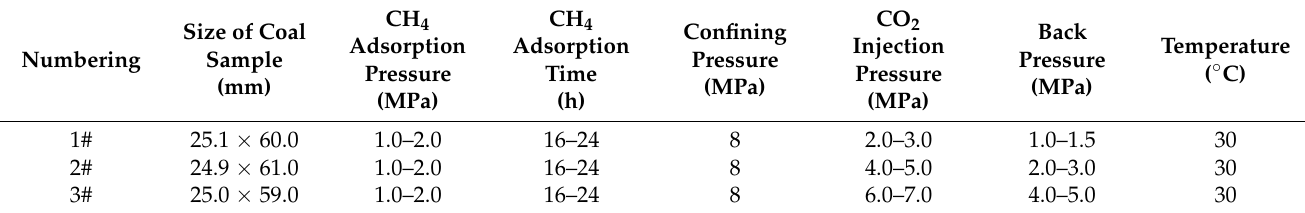
Table 1. The main parameters of displacement experiment.